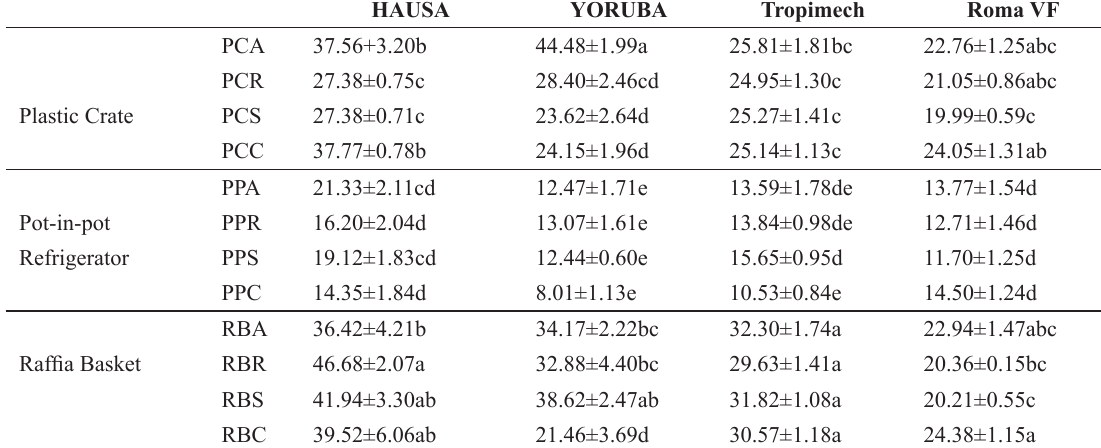
Table 2: Percentage weight loss of tomato fruits after 20 days of